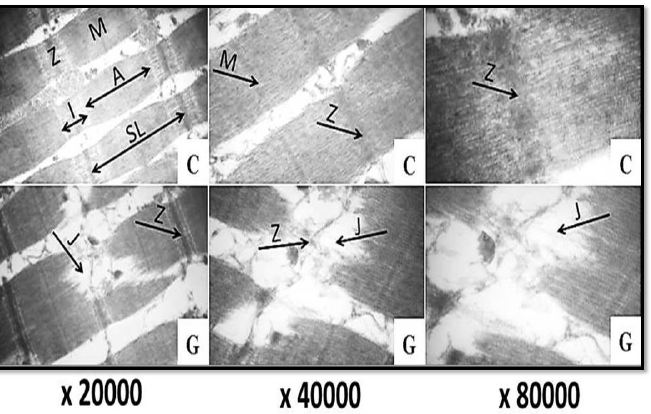
Figure 3. Transmission electron micrographs of camel semitendinosus muscle ( × 20,000, × 40,000, and × 80,000). C: control; G: ginger extract; A: A-band; I: I-band; SL: sarcomere length; Z: Z-line; M: M-line; J: junction between I-band and Z-line.